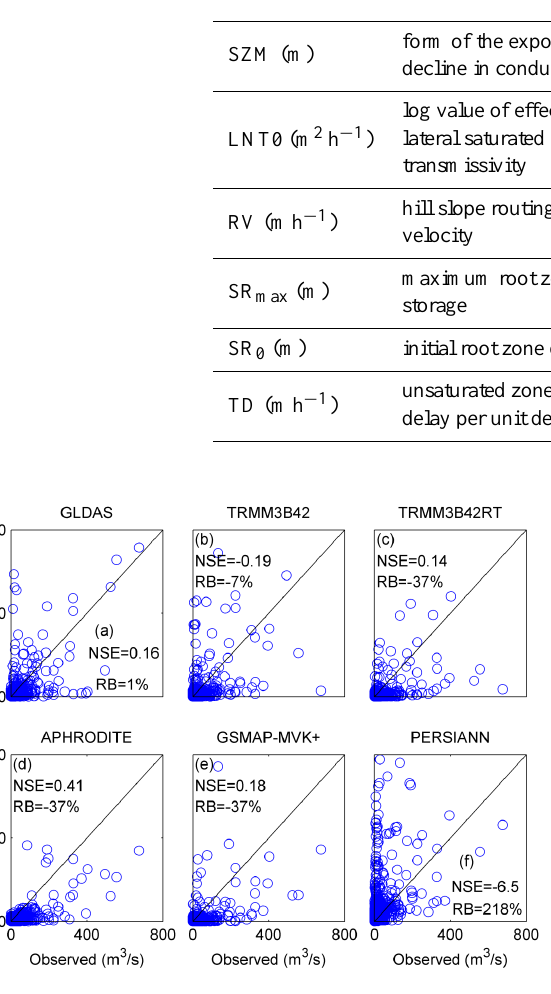
Figure 10. Scatter plots of simulated discharges with WEB-DHM against gauge observations at a daily scale.